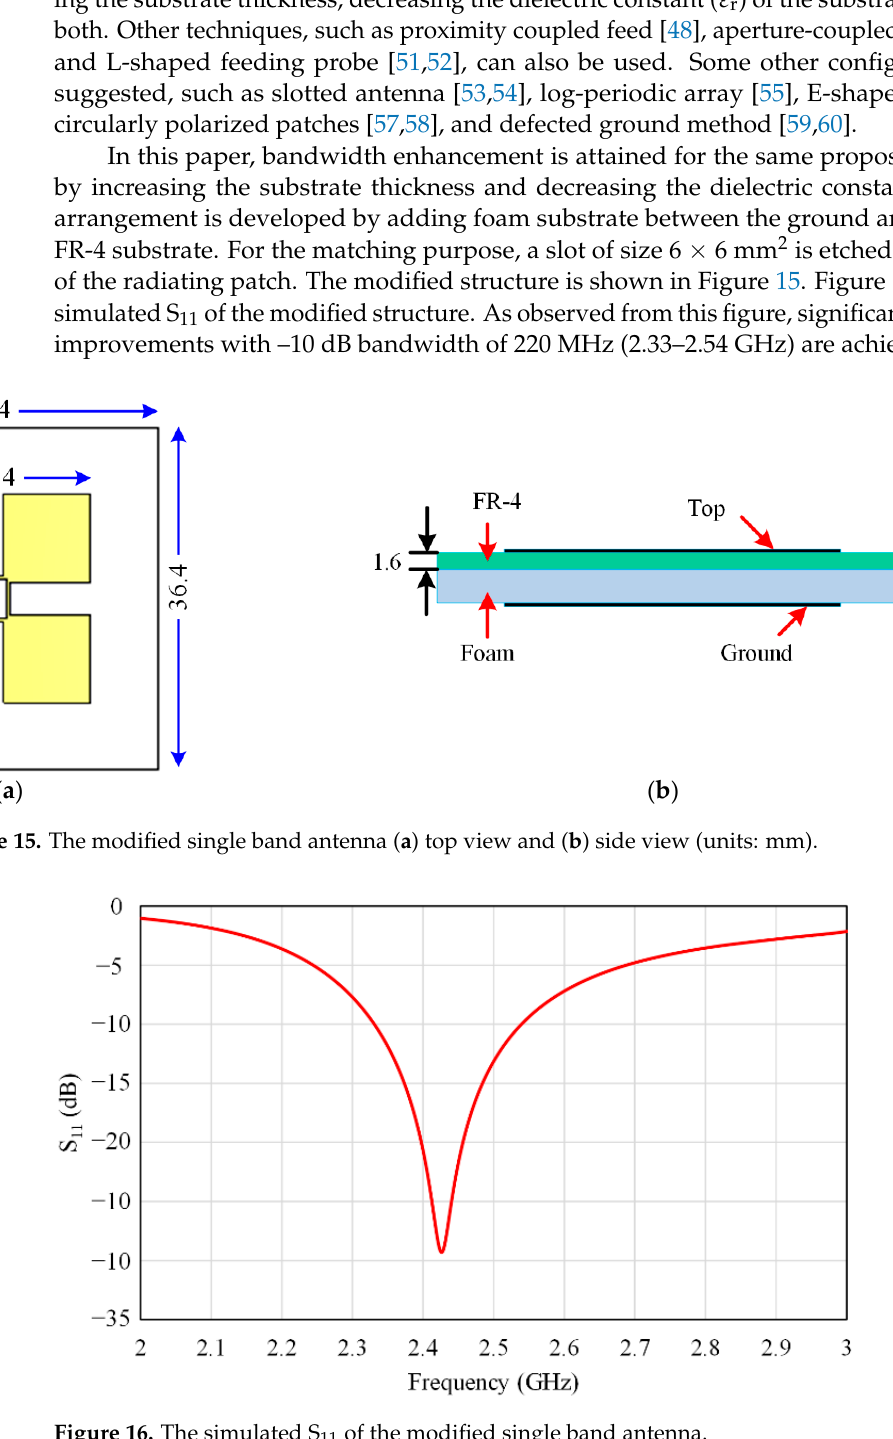
Figure 14. 2D radiation patterns of the dual-band slotted square patch antenna at ( a ) 2.4 GHz and ( b ) 2.8 GHz.